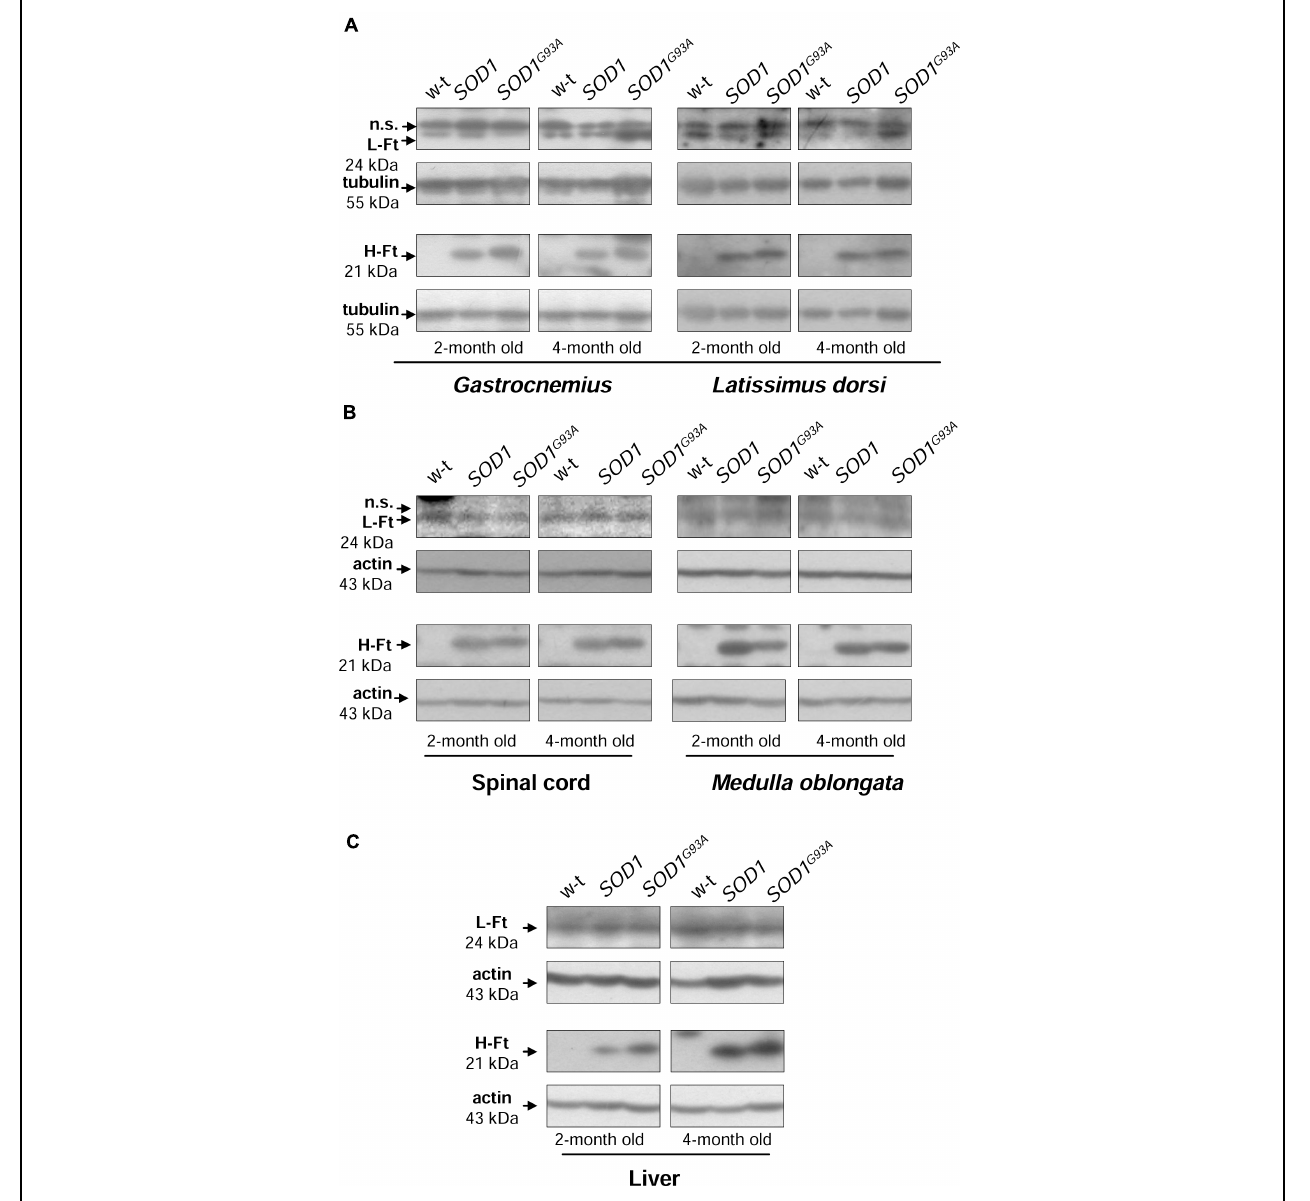
FIGURE 5 | Analysis of ferritin protein levels in tissues of experimental mice. Western blot analysis of L-Ft and H-Ft protein levels in skeletal muscle (A) , neuronal tissues (B), and liver (C) cytosolic extracts. Tubulin and actin were used as a loading controls, as indicated. n.s. – non-specific band detected with purified rabbit mouse liver ferritin antiserum. Data are representative for three independent Western blot analyses performed using extracts from 3 mice of each experimental group. The intensity of the H- and L-Ft bands (relative to the intensity of tubulin or actin bands) was quantified with a molecular Imager using Quantity One software (Bio-Rad) and is shown in arbitrary units to present proteins level (Supplementary Table). Statistically significant differences ( P < 0.01) in H-Ft protein levels were found between transgenic ( SOD1 and SOD1 G 93 A ) and wild-type mice in a given tissue and age